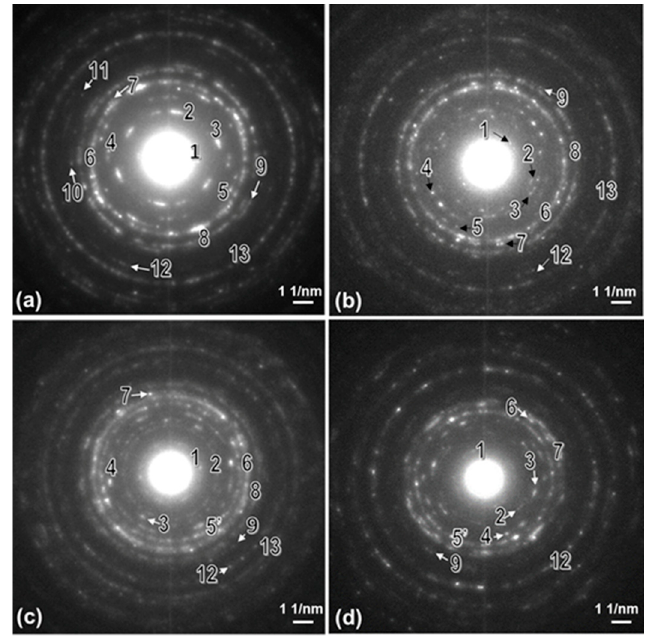
Figure 10. SAED pattern taken from the ( a ) bottom, ( b ) middle, and ( c ) top section of the recrystallized layer and ( d ) transition layer in the annealed Hf 7 B 10 Si 32 C 2 N 44 film.